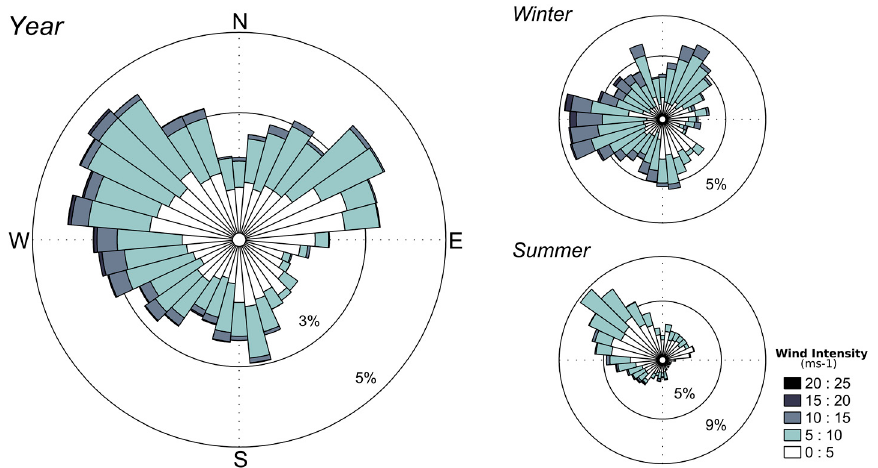
Figure 2. The wind regime in La Pallice station over the period 2015–2018. Winter and summer periods are also distinguished to characterise their variability in terms of direction and intensity. The legend box at right indicates the intensity of wind velocity in ms − 1.